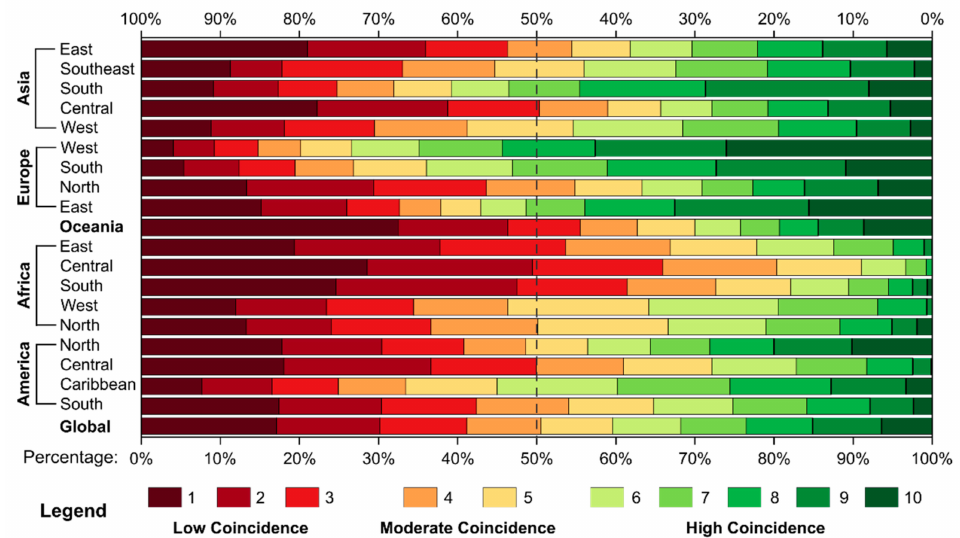
Figure 2. The percentage of di ff erent coincidence degrees of the cropland spatial distribution at the subcontinental